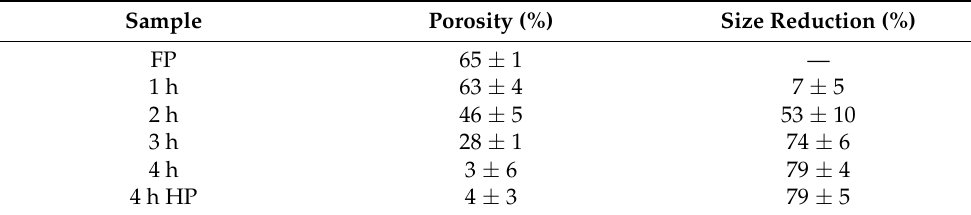
Table 1. Effect of treatment time on samples’ porosity and corresponding size reduction.